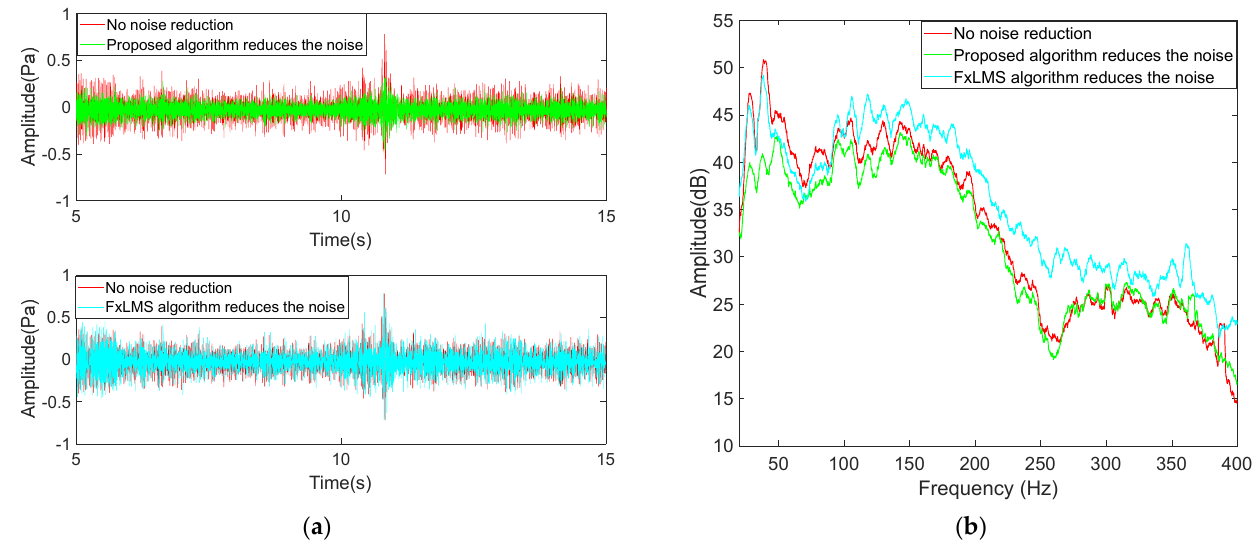
Figure 16. Experimental effect of noise reduction at a 50 km/h constant speed. ( a ) The time domain, ( b ) The frequency domain.